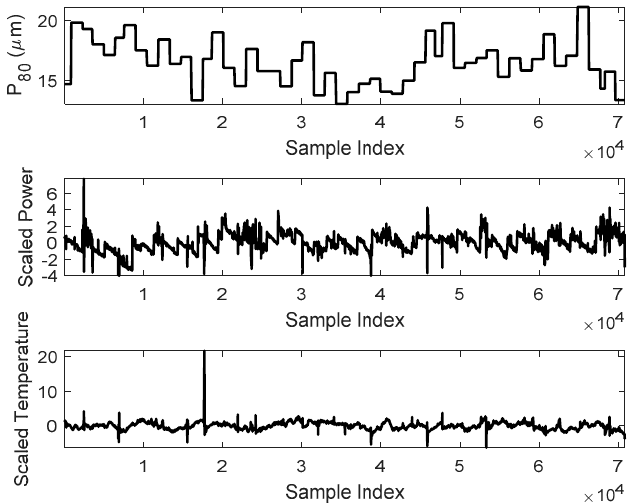
Figure 10. The raw time series of P 80 particle size (top), scaled power consumption (middle), and scaled temperature (bottom) of the IsaMill mill.